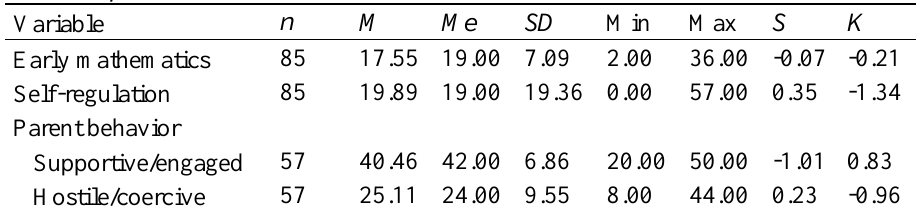
Descriptive statistics of the research variables Variable